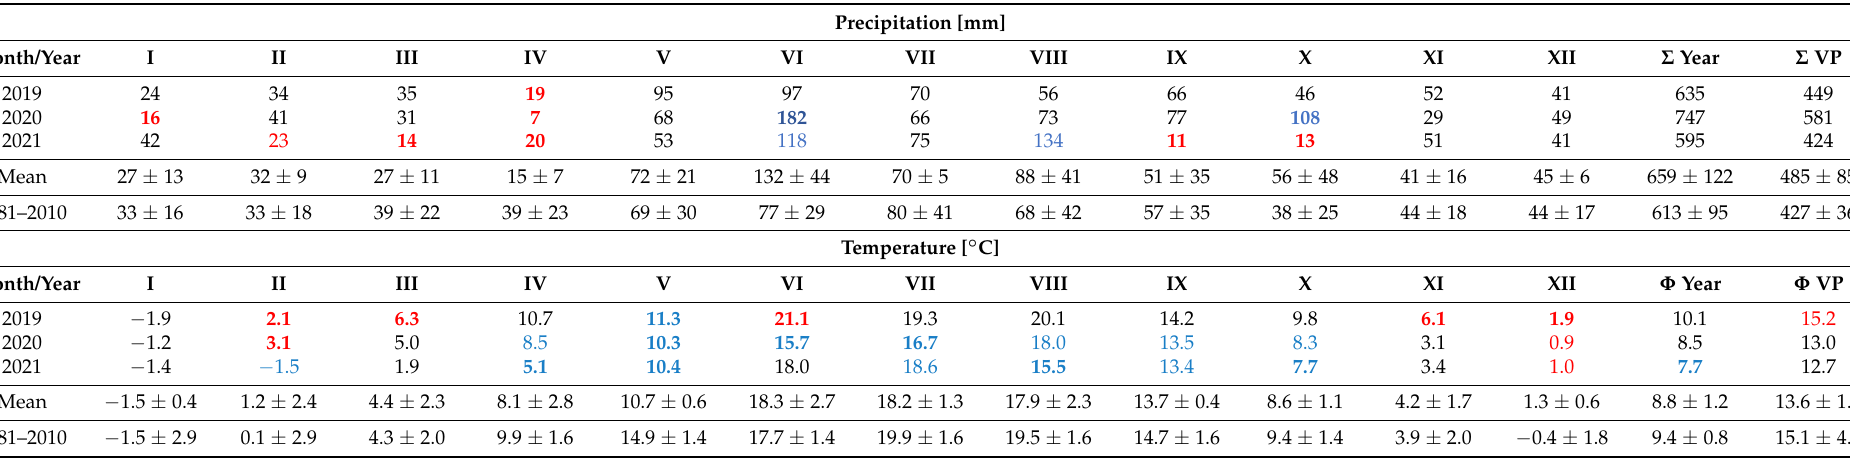
Table 2. Mean monthly, annual and seasonal (VP–vegetation period; i.e., from the second half of March until the first half of October) precipitation during 2019–2021, their mean and comparison with long-term normal 1981–2021 (Normal). Mean monthly, seasonal and annual air temperatures and their comparison with Normal. The monthly precipitation recorded during 2019–2021 was as follows: more than 70% less than Normal (red); 50–70% less than Normal (bold red); more than 30% more than Normal (blue) and double that of Normal (bold blue). The monthly temperatures recorded during 2019–2021 were: ca. 1–2 ◦ C lower than Normal (blue); more than 2 ◦ C lower than Normal (bold blue); ca. 1–2 ◦ C higher than Normal (red) and 2 ◦ C and higher than Normal (bold red). The values are supplemented with standard deviations ( ± SD). Months are represented by Roman numerals.